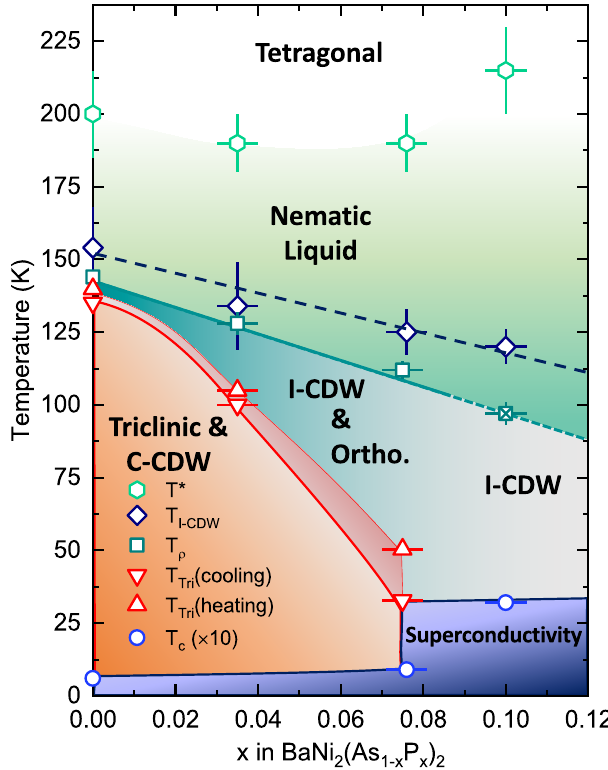
Fig. 5 | Phase diagram for BaNi 2 ð As 1 (cid:2) x P x Þ 2 . The transition temperatures for the triclinic phases are determined from transport and thermal expansion measure- ments. We also report the temperature T ρ of the minimum in dR/dT which corre- sponds to an orthorhombic transition in the parent compound (Supplementary Note 2). The superconducting transition temperature is measured by speci fi c heat (SupplementaryNote2).TheonsetoftheC-CDWseenwithXRDcoincideswiththe triclinic transition, whereas the intensity of the I-CDW satellites increases strongly at T I-CDW , just above T ρ (see Fig. 2). The onset of the broadening of the E g,1 Raman phonons is indicated by T * (see also Supplementary Note 3). Horizontal error bars correspond to the uncertainty on the P-concentration as determined from EDX (Supplementary Note 1). Vertical error bars re fl ect the accuracy with which the various temperatures can be determined from Fig.